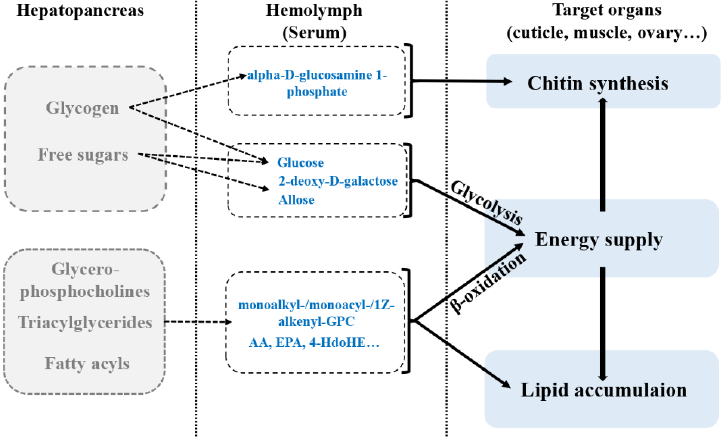
Figure 6. Metabolic profiles in serum of mud crabs post-pubertal molt. Blue, significantly decreased postmolt; gray, not detected.